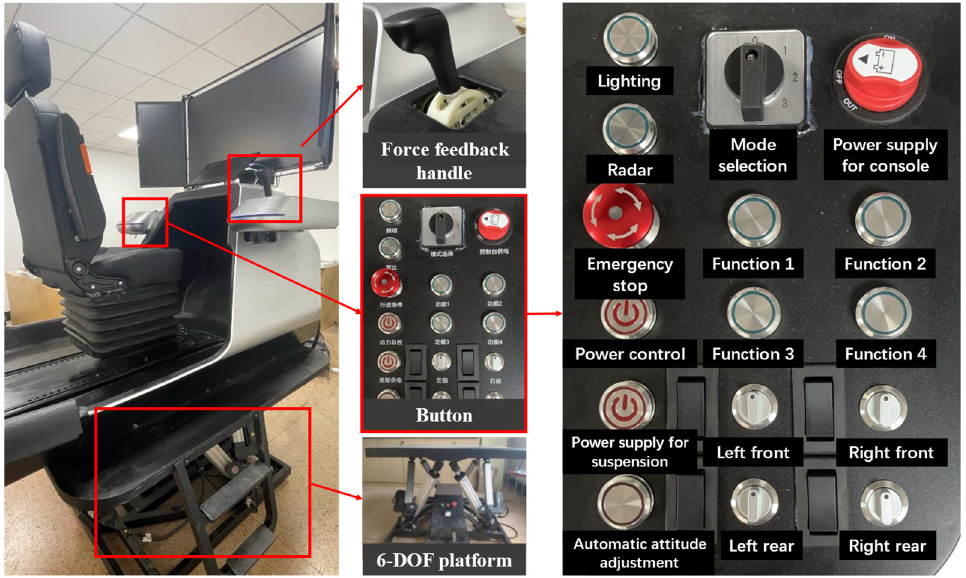
Figure 15. Motion simulation and human–computer interaction system.